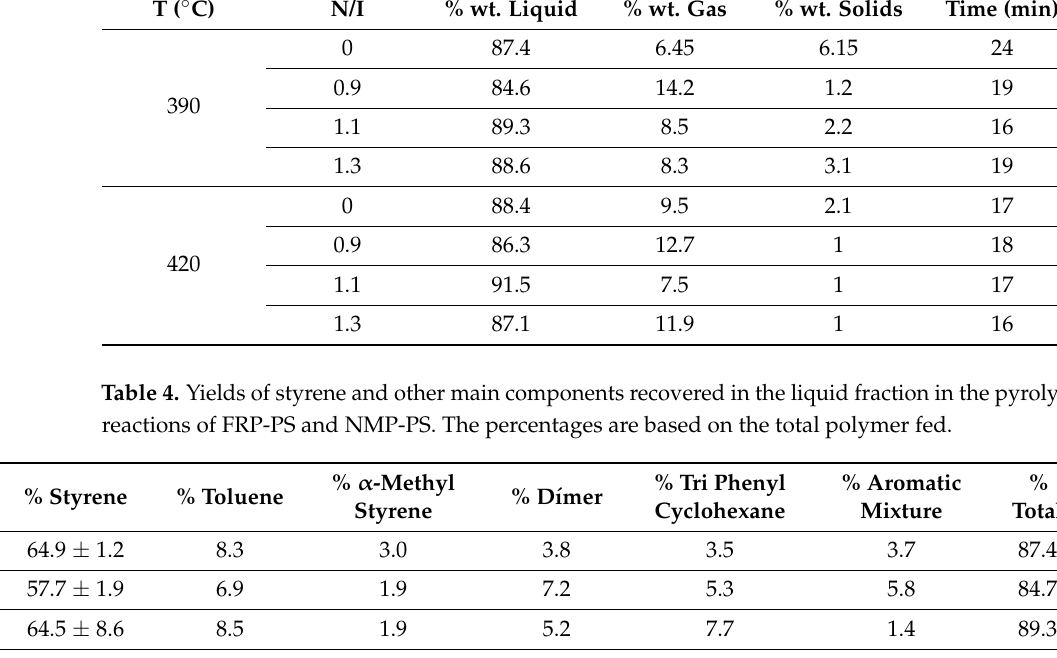
Table 3. Yields of liquid, gas, and solids fractions in the pyrolysis reactions of FRP-PS and NMP-PS and reaction times.